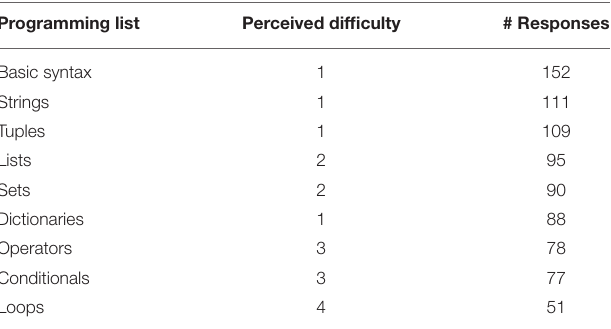
TABLE 8 | The average level of difficulty perceived by the students in the programming exercises. Programming